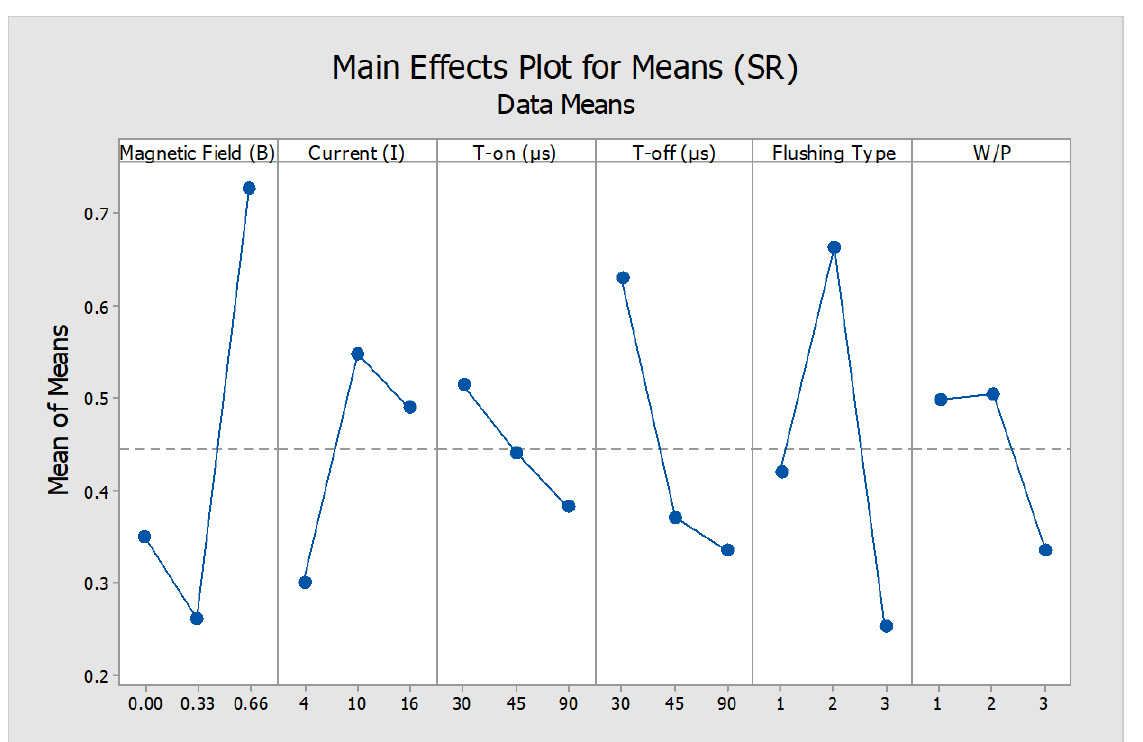
Figure 8. Main effects plot for surface roughness (µm). The interaction between various process parameters was statistically analyzed at 95% confidence level (i.e., p ≤ 0.05). It was observed that the interaction between magnetic field intensity (B) and T-on significantly affected the surface roughness. From Figure 9, it is depicted that the surface roughness enhanced at high magnetic field intensity and low T-on value. From the SEM analysis (Figure 10a), it can be observed that non-uniform surface with significant undulations is visible prominently during machining in SiC mixed dielectric medium in comparison to graphite mixed dielectric (Figure 10b). The high thermal